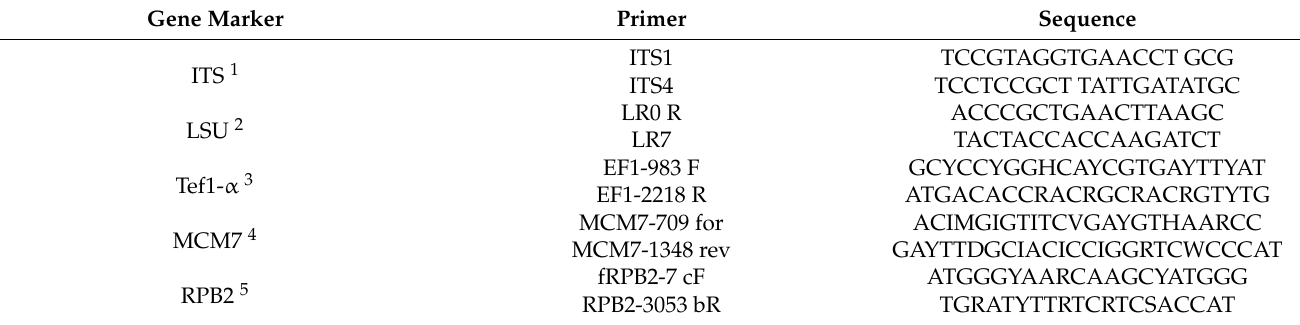
Table 1. Primer information used in this